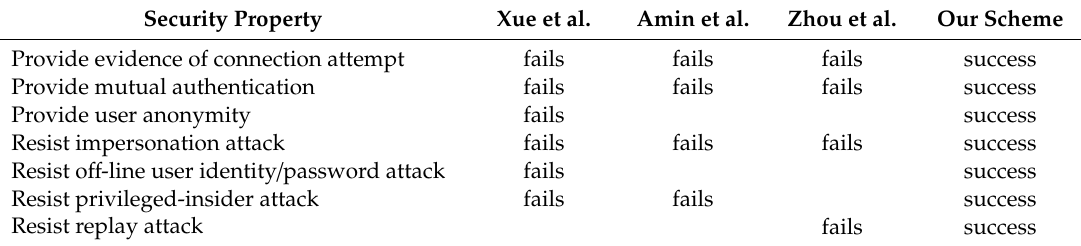
Table 2. Security